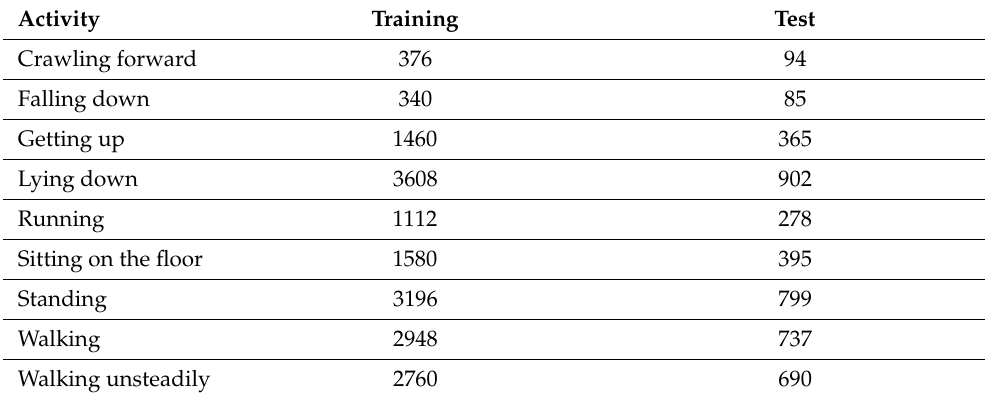
Table 4. The data set acquired through our